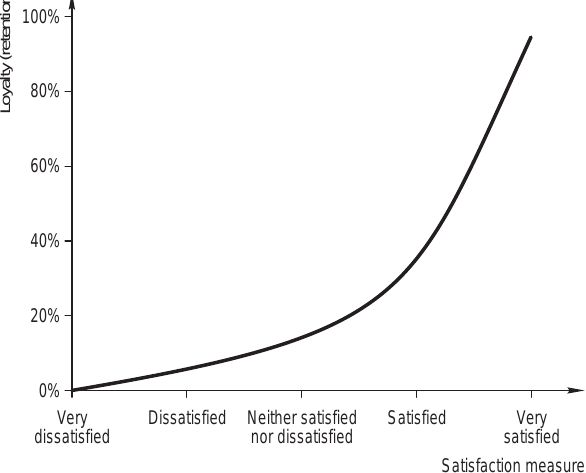
Fig. 1. The relationship between satisfaction and loyalty/retention. Source: Heskett et al. (1997)